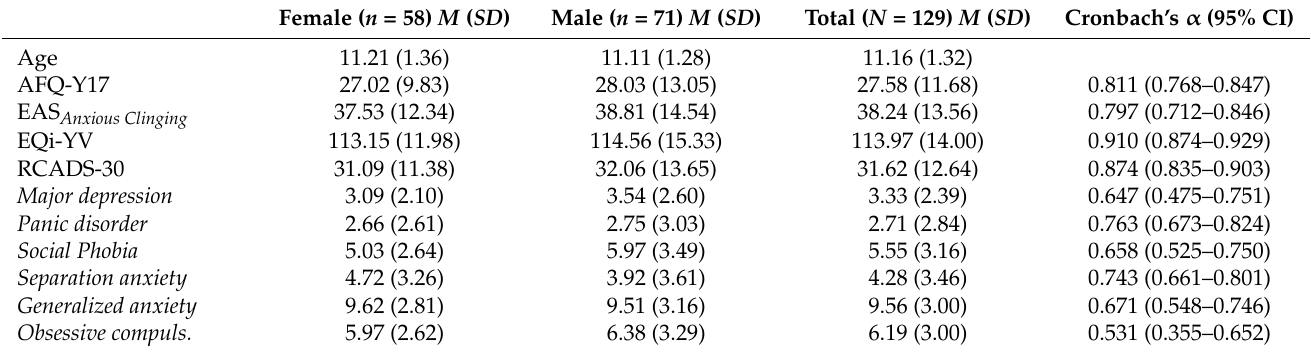
Table 4. Psychological inflexibility, anxious clinging, emotional intelligence, and mental health symptoms in students aged 9–14.